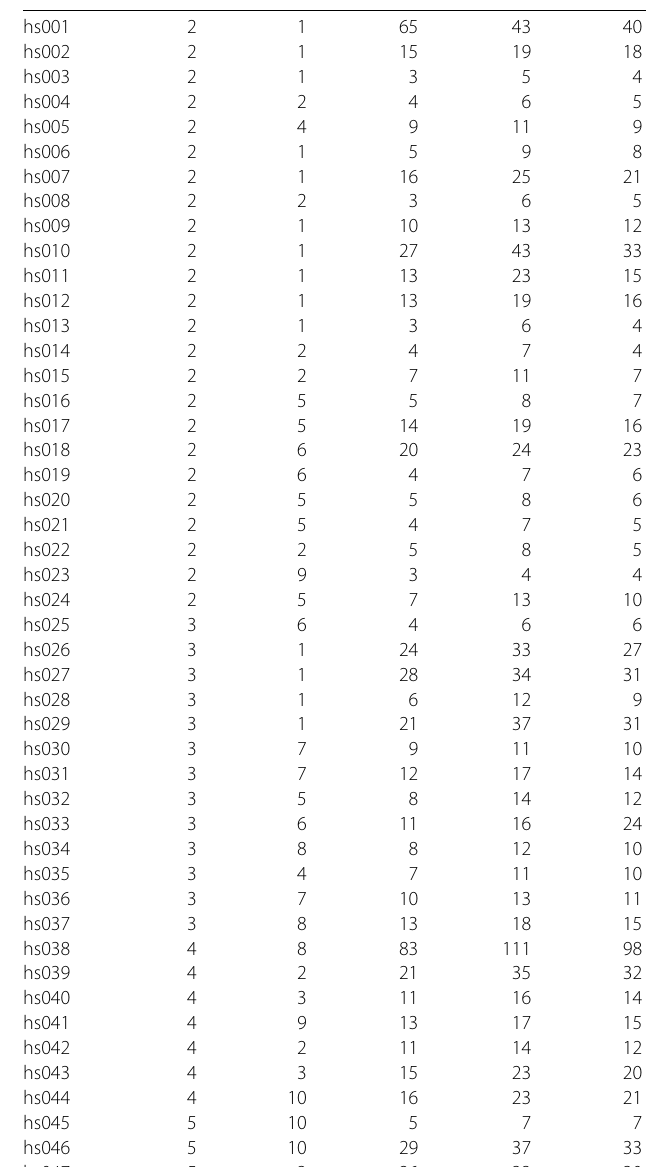
Table 1 Numerical results on the NFQPIM for some constrained optimization